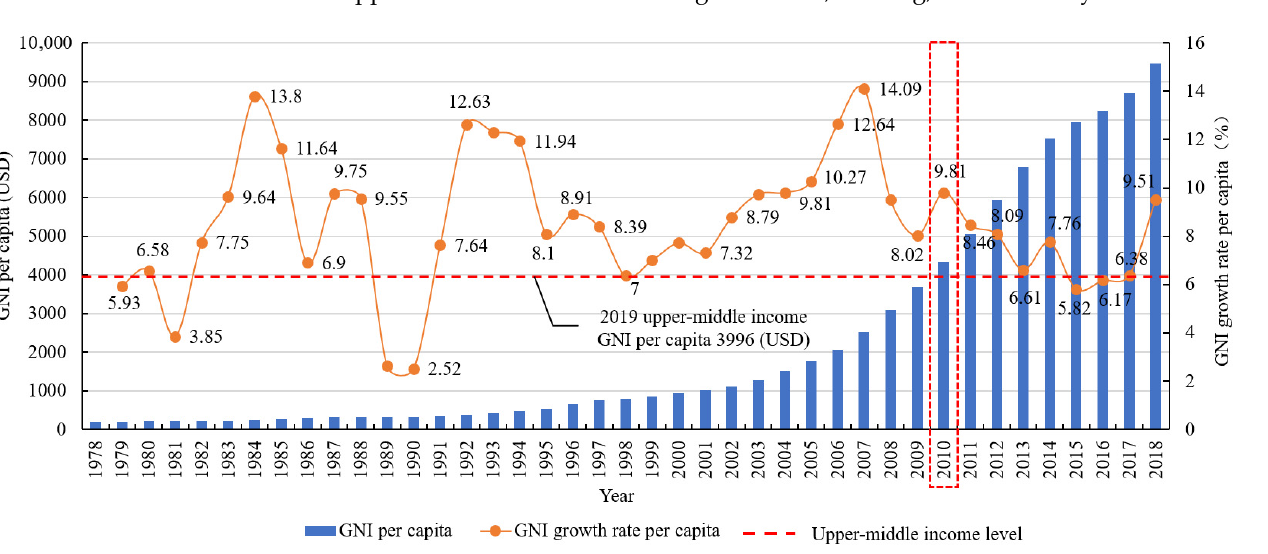
Figure 1. Changes in per-capita gross national income and its growth rate since China’s reform and opening up. Data source: World Bank.